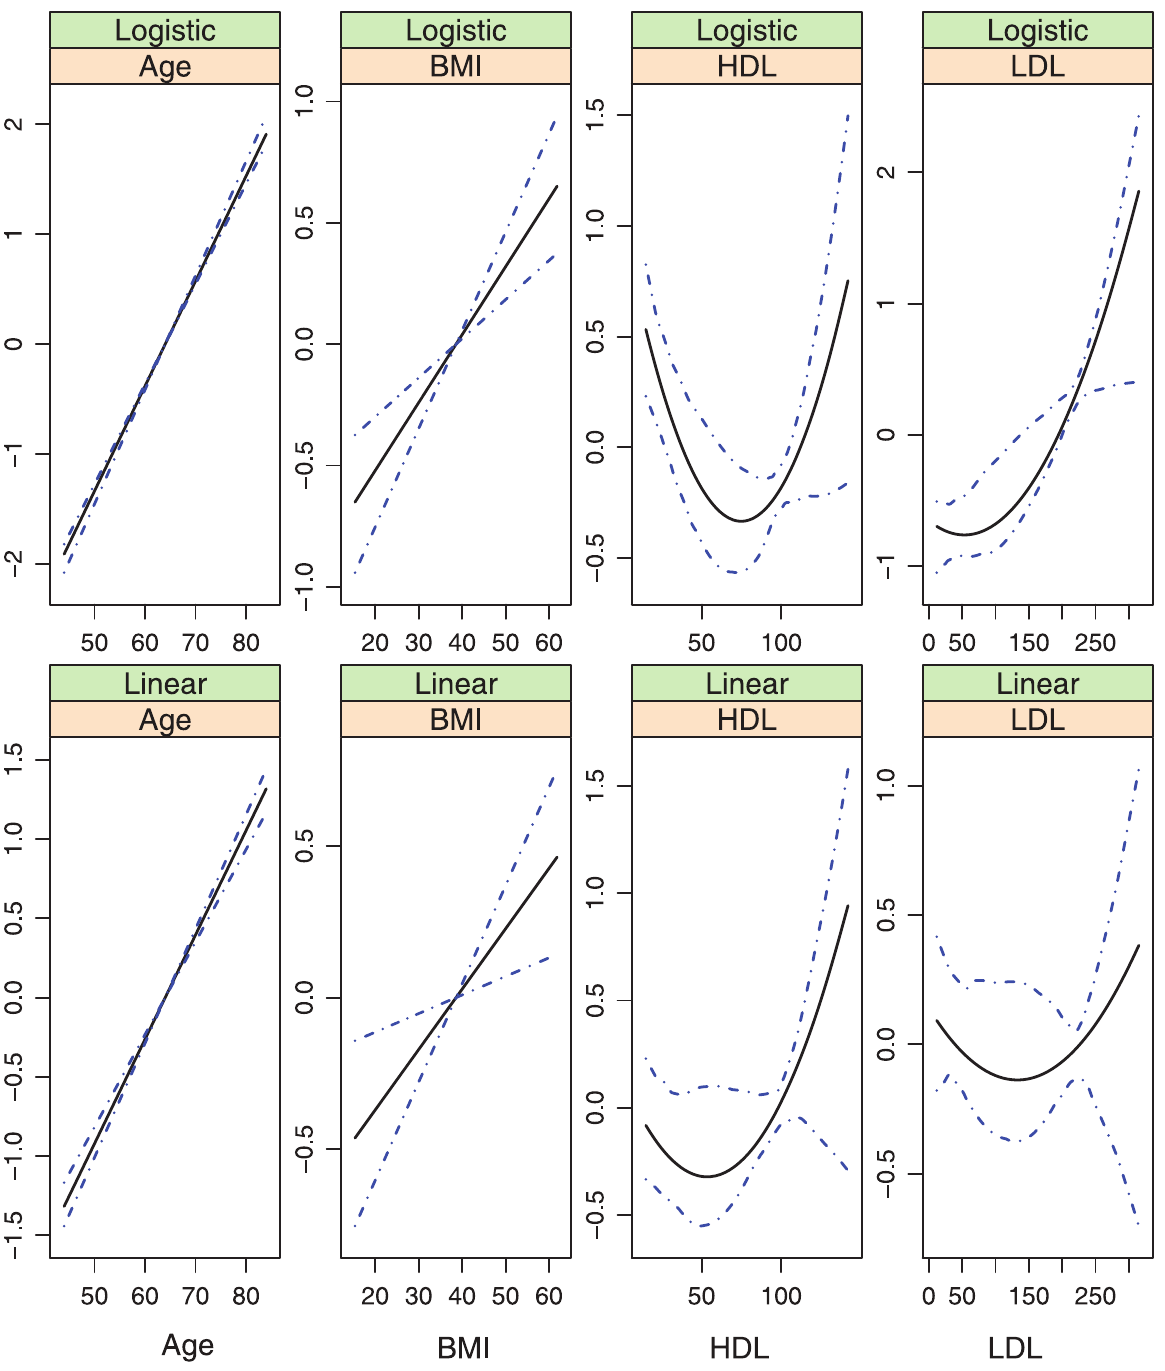
Figure 5. Model (ii.2): estimated covariate effects for age, BMI, HDL, and LDL. The solid line is the estimate. The dash-dotted lines are the point-wise 95% confidence intervals. The y-axis is the value of the function.